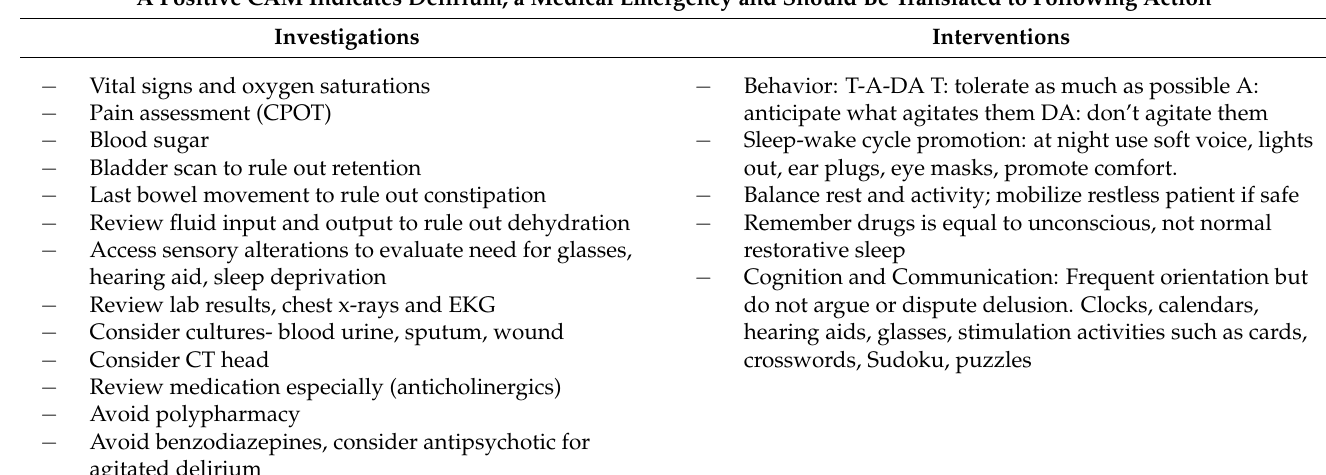
Table 3. Delirium care strategies: the delirium order set.